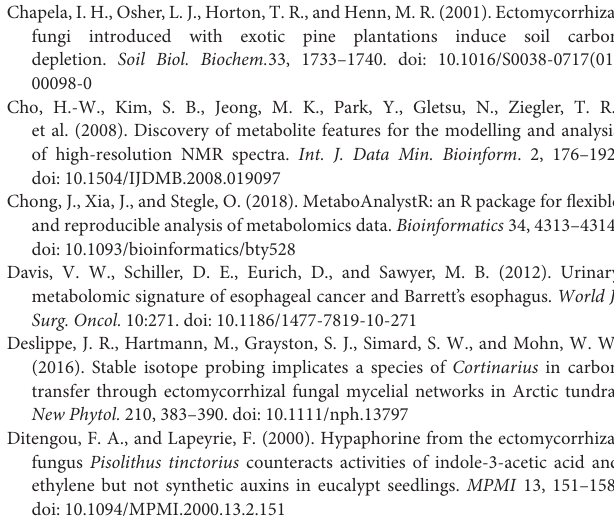
Supplementary Table 5 | GO analysis of differentially expressed genes in E. grandis. GO enrichment result including the GO ID, description of the GO, condition, p -value (p.Val), false discovery rate (FDR), and the counts and names of genes involved in the GO